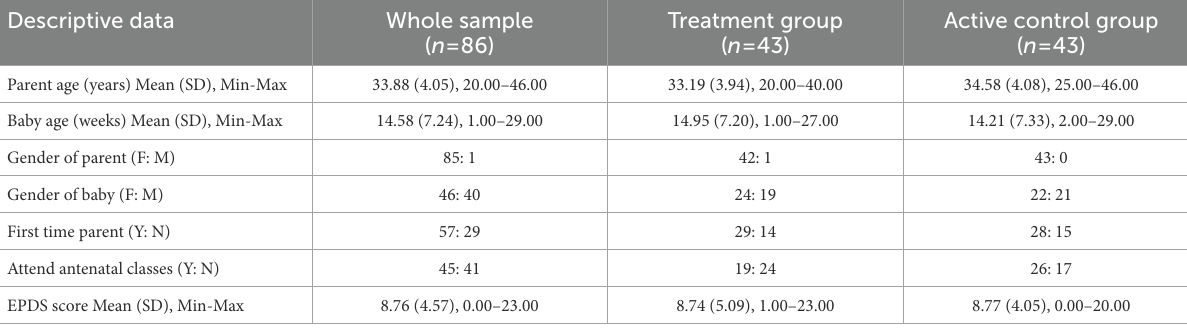
TABLE 1 Descriptive data for the final sample in the trial ( n =